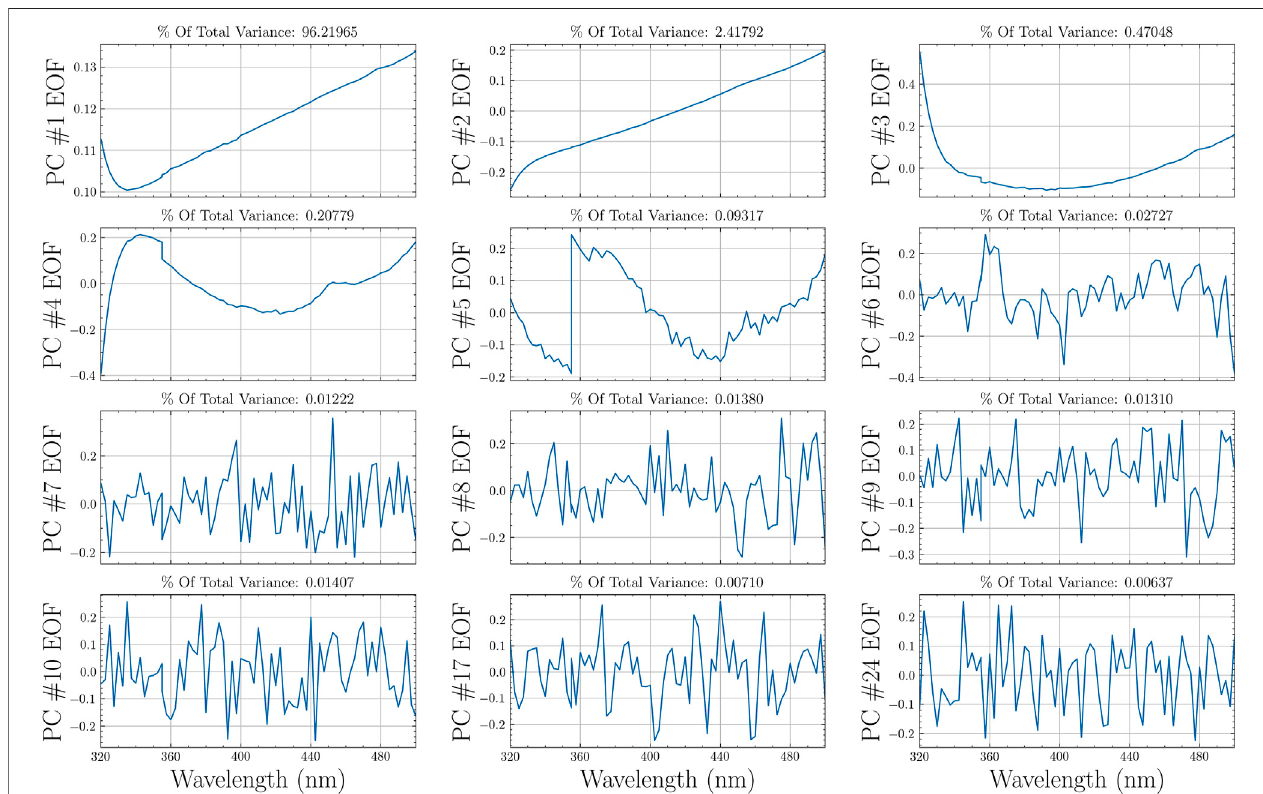
FIGURE 2 | Orthogonal functions decomposed from OMI measurements from 2 days each month in 2005 (excluding March). The leading 10 EOFs are shown as well as lower ranked EOFs 17 and 24.